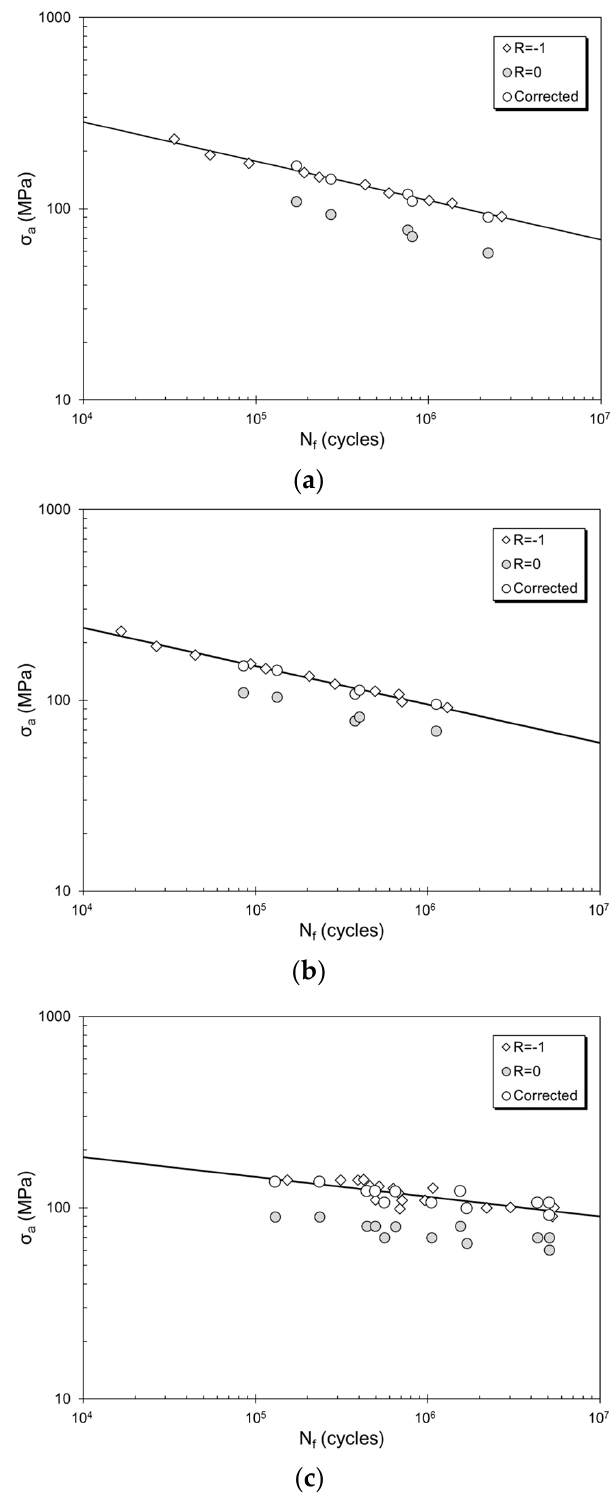
Figure 1. The S–N curves at R = − 1 after Walker mean stress correction for ( a ) sand cast F357 by Jana et al. [37], ( b ) A357 by Mu et al. [35], and ( c ) friction stir processed F357 by Jana et al. [37]. The original data for R = 0 as well as their correction according to Walker equation (Equation (2)) are also